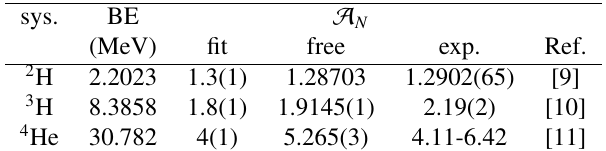
Table 2. Binding energies (in MeV) and dimensionless ANCs of one nucleon separation for light nuclei. ANCs are calculated by fitting the energy shifts in a box (fit), deduced directly from the free-space wave function (free), and compared also to the values extracted from experiments (exp.).